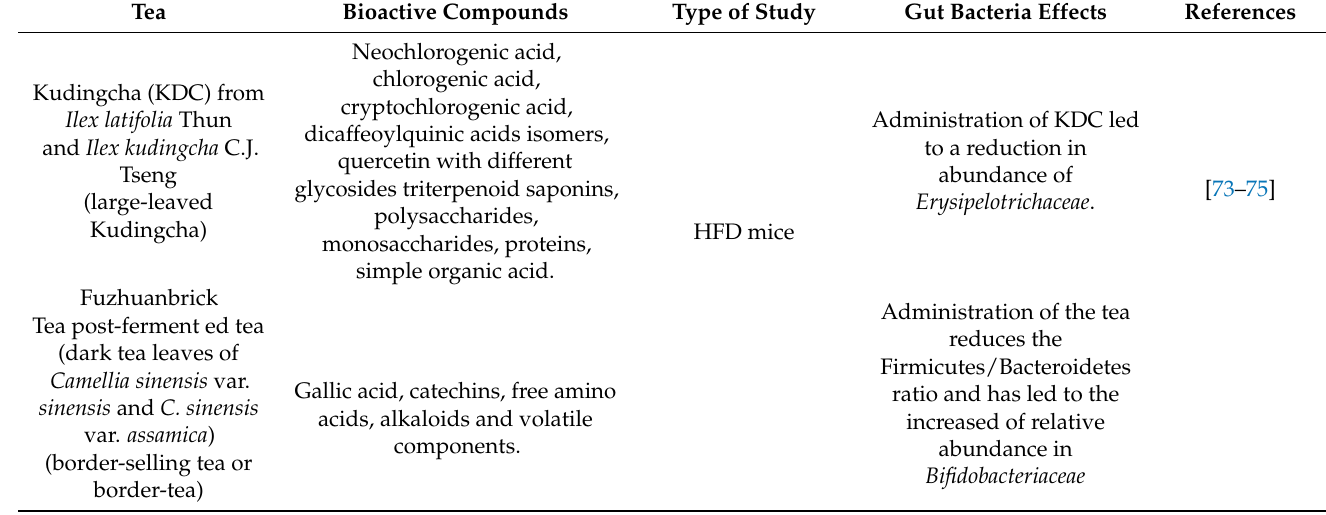
Table 4. Tea bioactive compounds and their effects on gut